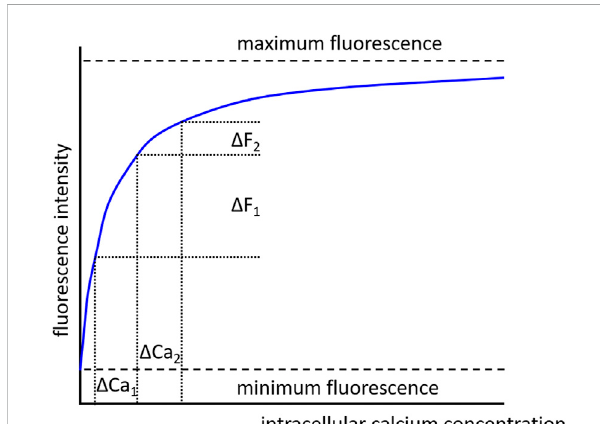
FIGURE 11 Dependence of fl uorescence intensity on calcium concentration. In the absence of calcium, the dye is free of calcium and minimum fl uorescence is observed. With increasing calcium concentration the dye binds increasingly more calcium ions, but when all dye molecules are occupied by calcium ions a maximum fl uorescence is achieved. There is a non-linear dependence of fl uorescence intensity on calcium concentration. Consequently, similar changes in calcium concentration ( Δ Ca1 = Δ Ca2), when evoked from different initial calcium concentrations, produce different changes in fl uorescence intensity ( Δ F1 > Δ